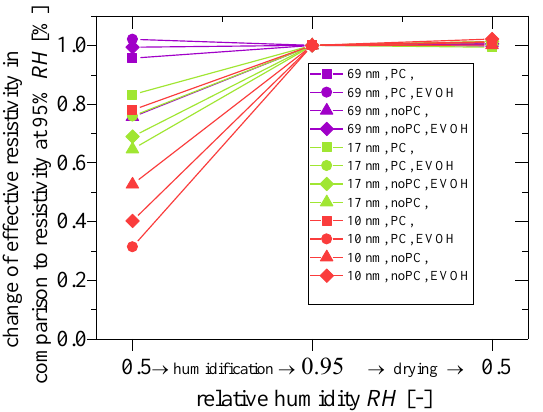
Figure 8. After humidification and subsequent drying, the differently coated Metalkote paper samples did not regain their initial resistivity values. PC/noPC = paper surface with/without pigment coating.